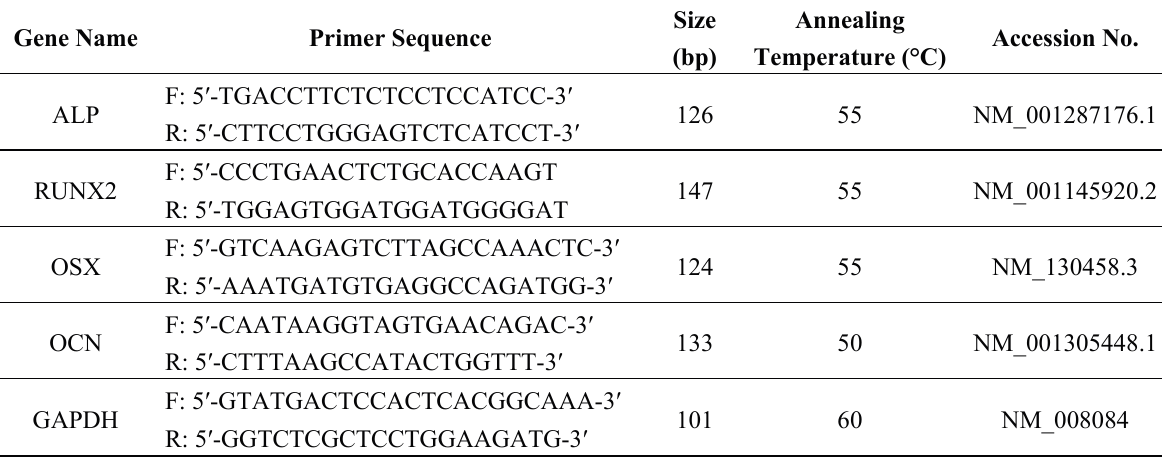
Table 1. Primer sets and annealing temperature for